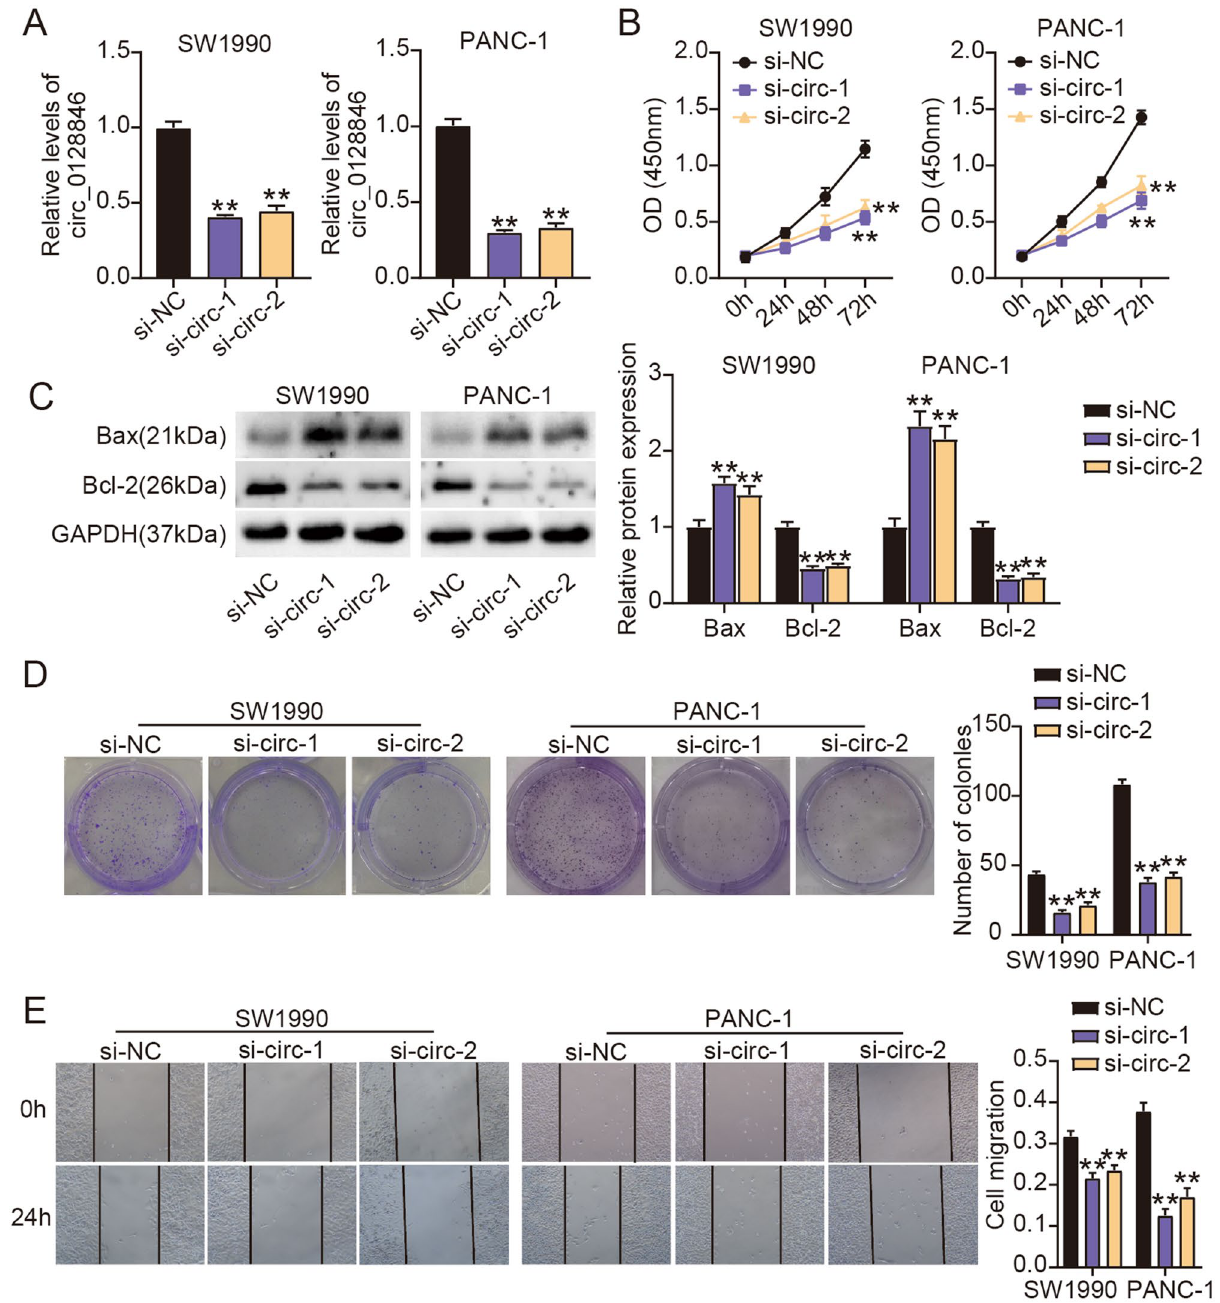
Figure 2. Silencing circ_0128846 restrained PC cell proliferation, colony formation and migration whereas enhanced cell apoptosis. ( A ) Circ_0128846 expression in SW1990 and PANC-1 cells transfected with two si-circ_0128846 (si-circ-1, si-circ-2) or si-NC was checked by RT-qPCR. ( B ) The effect of circ_0128846 silencing on cell proliferation was assessed by CCK-8 assay. ( C ) The expression of apoptosis-related proteins (Bax and Bcl- 2) affected by circ_0128846 silencing was examined by western blotting. ( D ) The effect of circ_0128846 silencing on clone formation ability was assessed by colony formation assay. ( E ) The effect of circ_0128846 silencing on cell migration was assessed by wound healing assay. ** P < 0.001 relative to